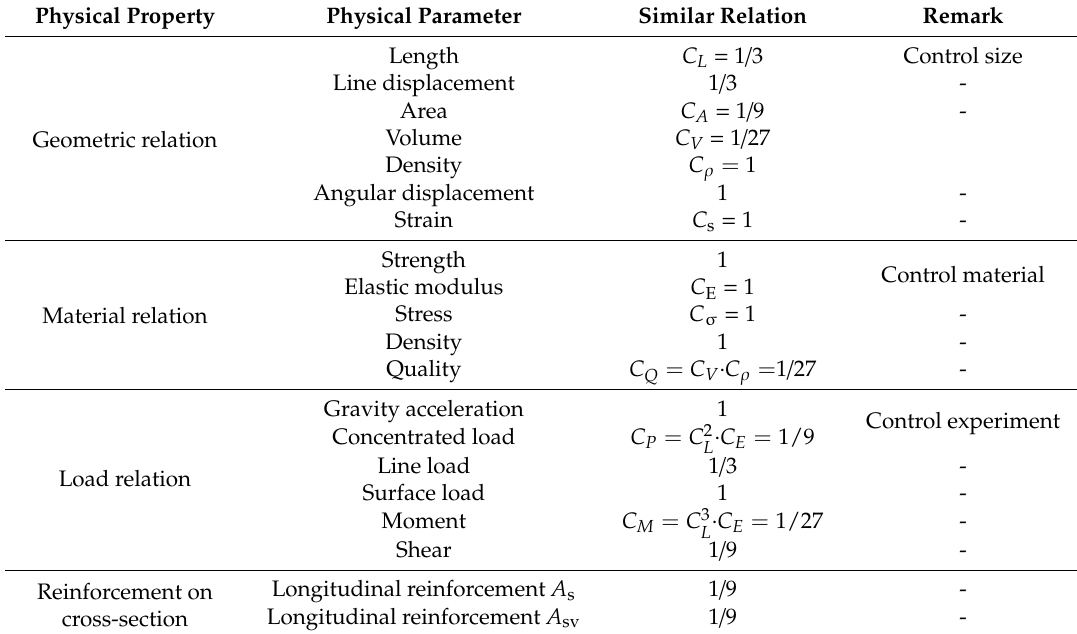
Table 2. Similar relationships between the experimental scale model and the original prototype.